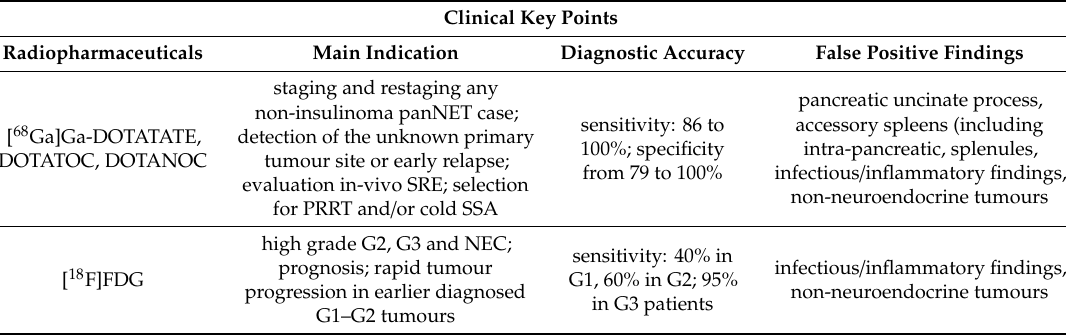
Table 1. Summary of the main clinical key points of the two EANM / ENETS recommended radiopharmaceuticals.